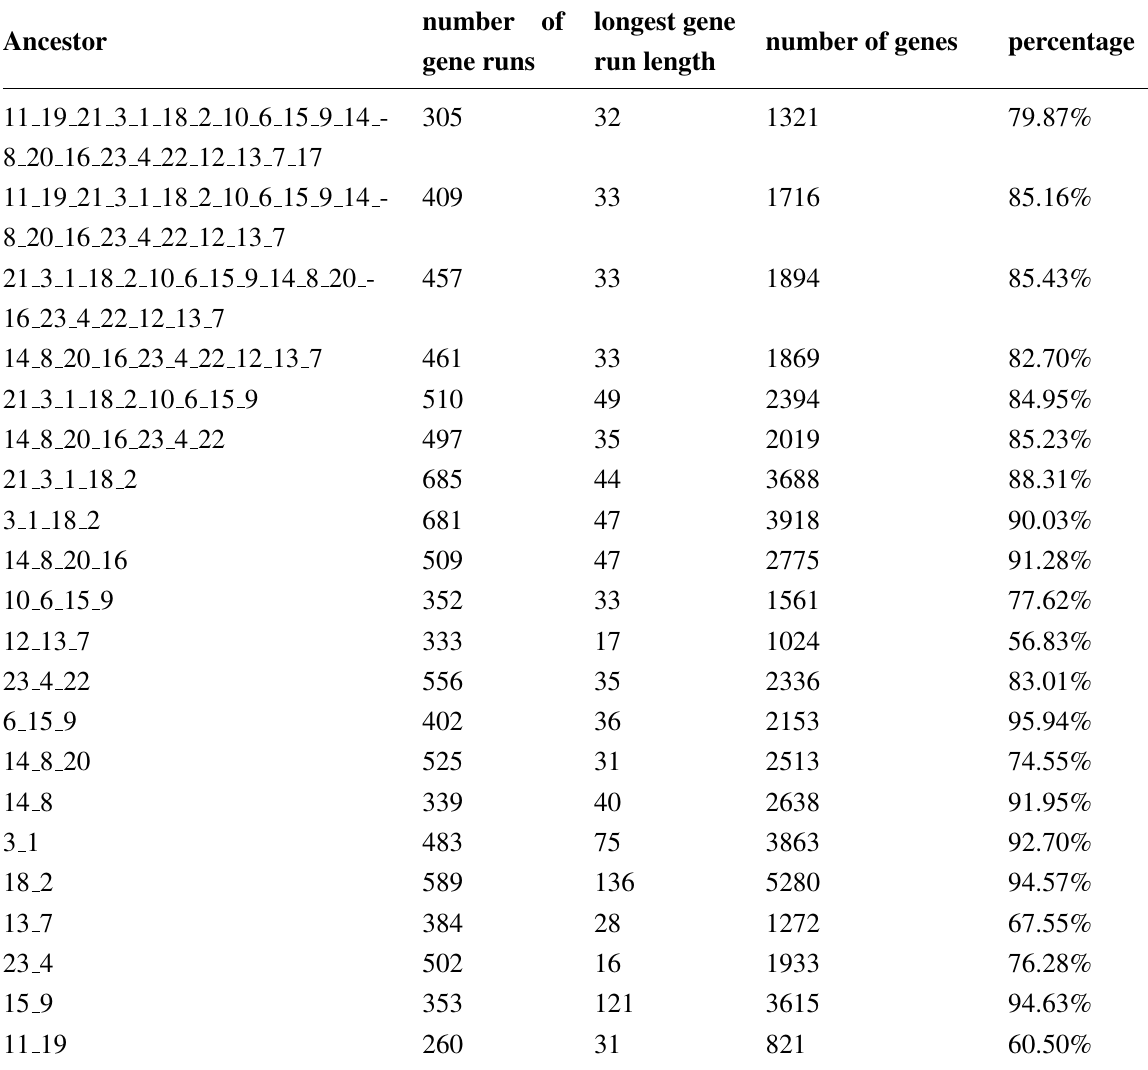
Table 3. Contiguous gene run reconstruction overview of the Rhizobiales group. Length of the gene runs is measured in genes. The number-of-genes column shows the total number of genes on all gene runs and the percentage column shows the coverage of the gene